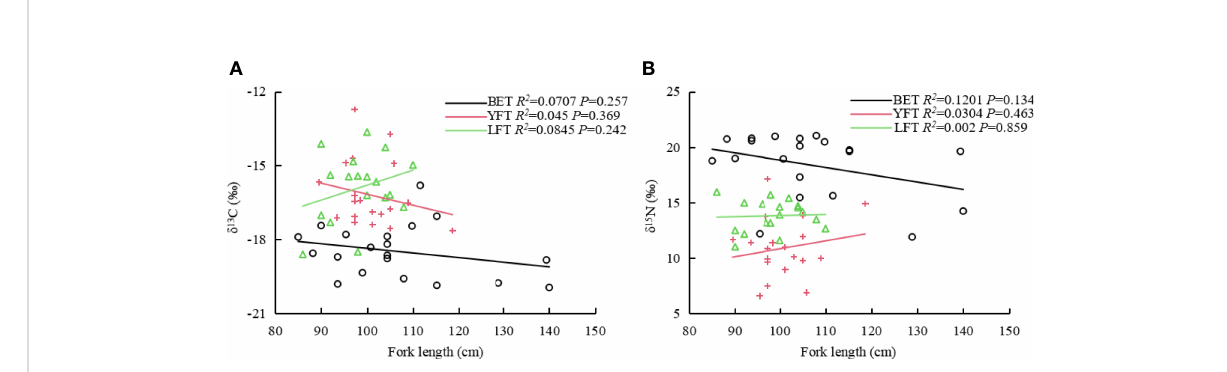
FIGURE 4 Correlation between fork lengths of three tuna species and d 13 C (A) and d 15 N (B) . BET: big eye tuna, Thunnus obesus ; YFT, yellow fi n tuna, T. albacares ; LFT, albacore tuna, T. alalunga .